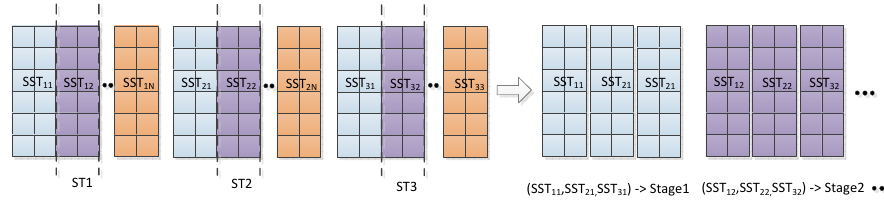
Figure 3. An illustrated example for table